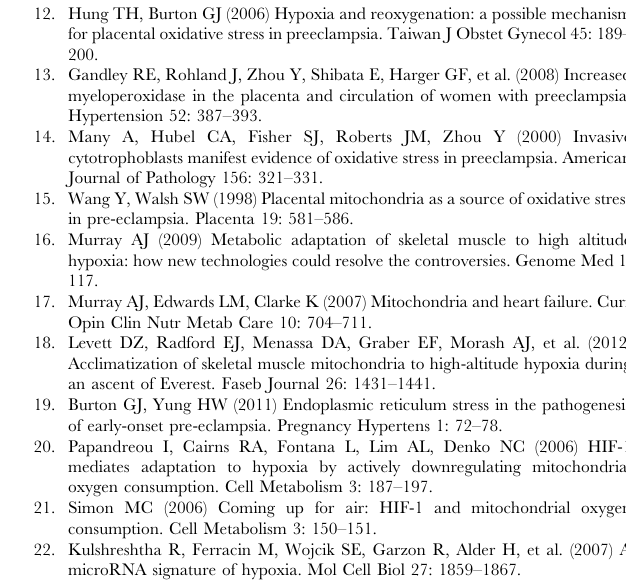
Figure S2 Treatment with a sublethal dose of tunica- mycin (2.5 m g/ml) or thapsigargin (0.4 m M) downregu- lates ETS protein levels in BeWo cells. A) Protein levels of ETS complexes I–IV and V (ATP-synthase) in BeWo cells. *p , 0.05, **p , 0.01 compared with cells cultured without tunicamycin or thapsigargin. Three biological replicates for control and treated cells were